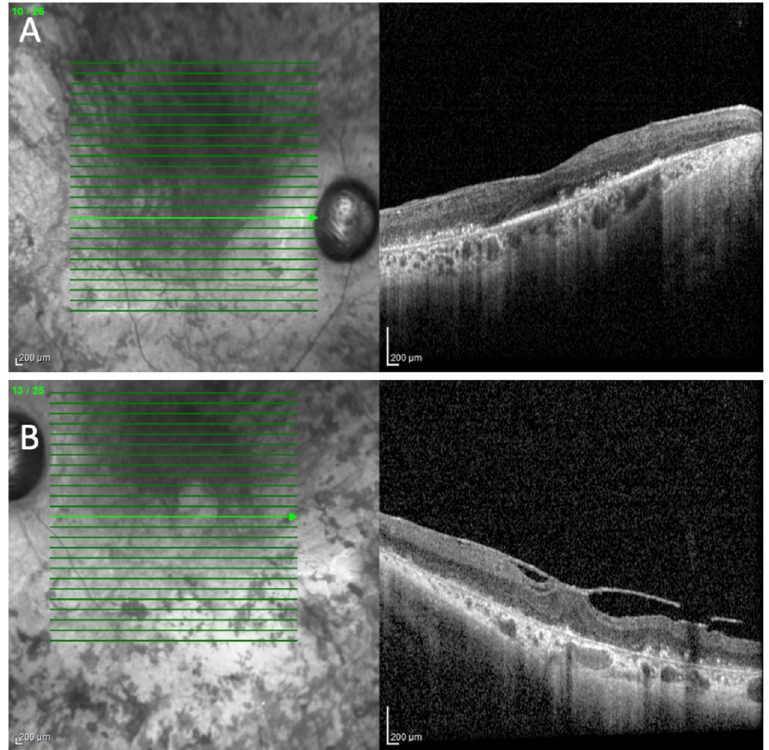
Figure 1. Spectral domain OCT scan (HRA+ OCT Spectralis ® ) of the right ( A ) and left ( B ) eyes depicting prominent sub-RPE deposits and epiretinal membranes on both eyes with vitreoretinal traction on the left eye.